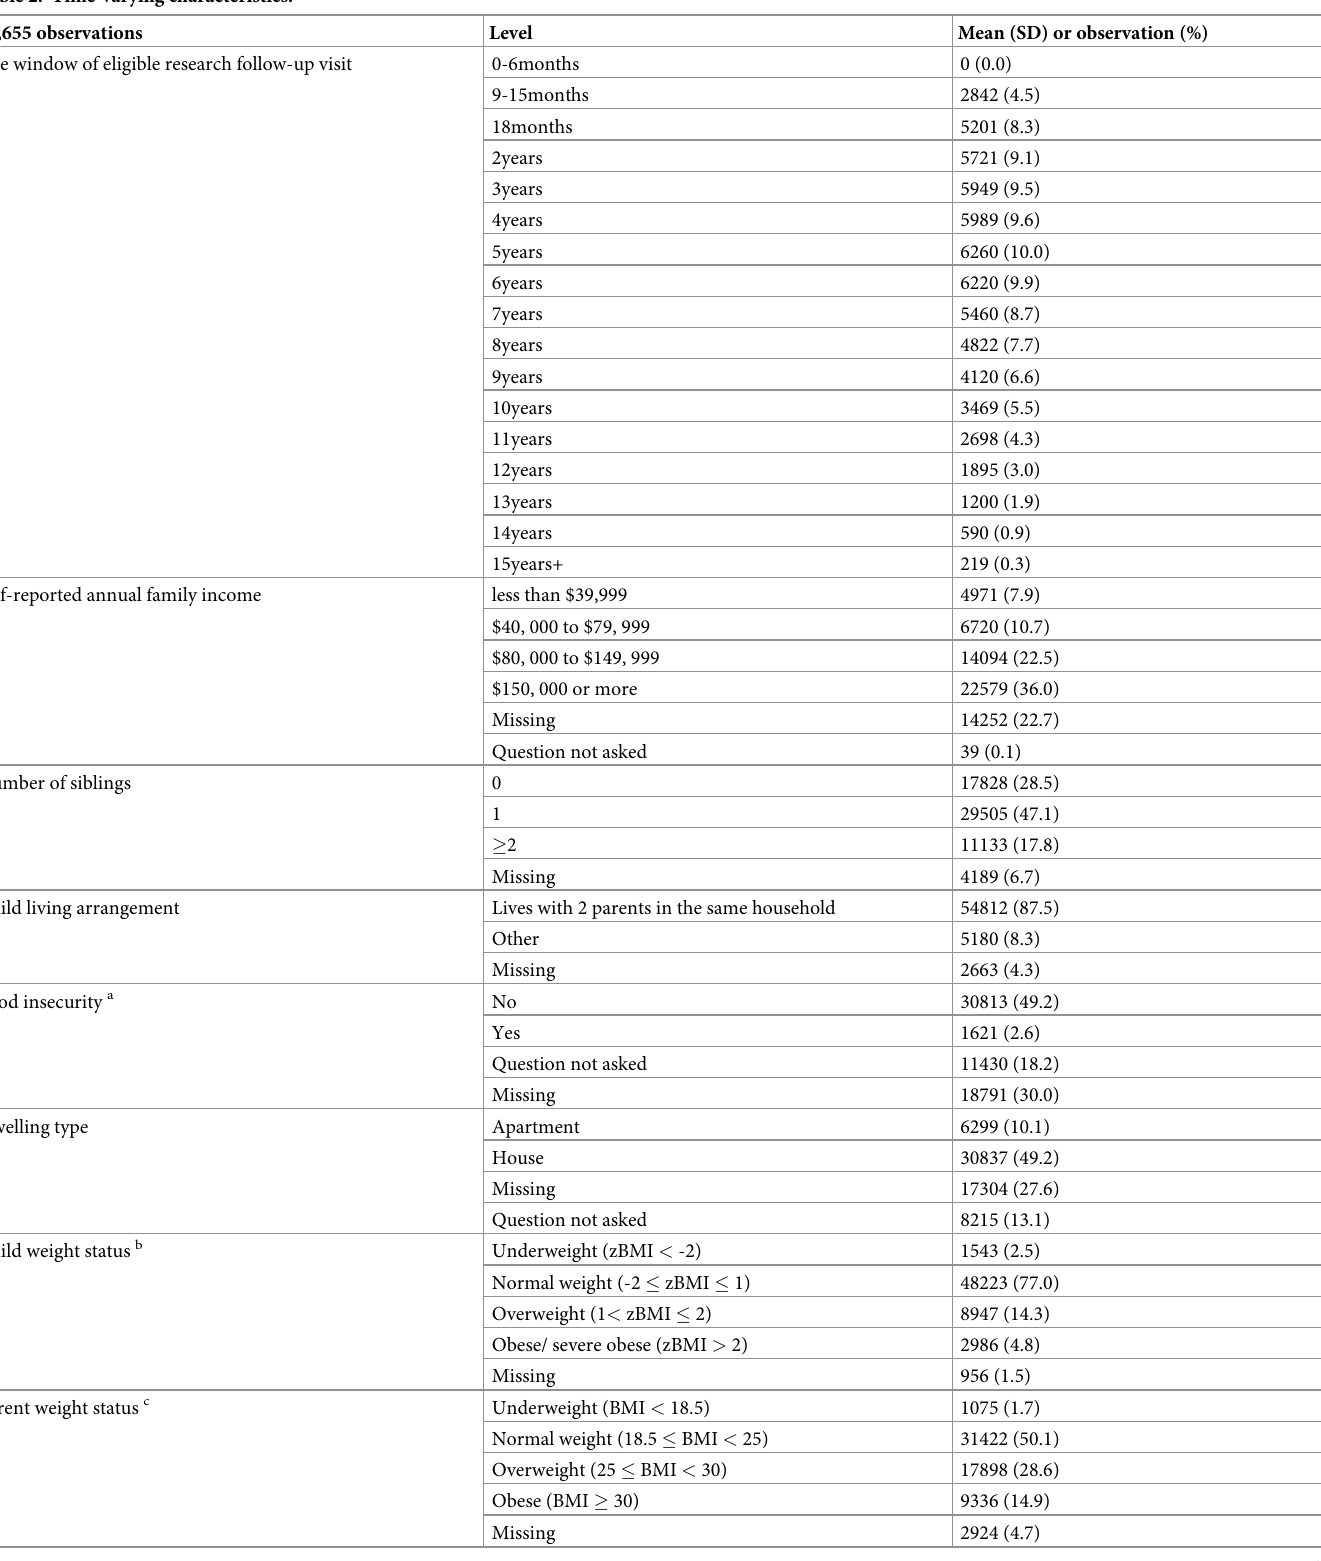
Table 2. Time-varying